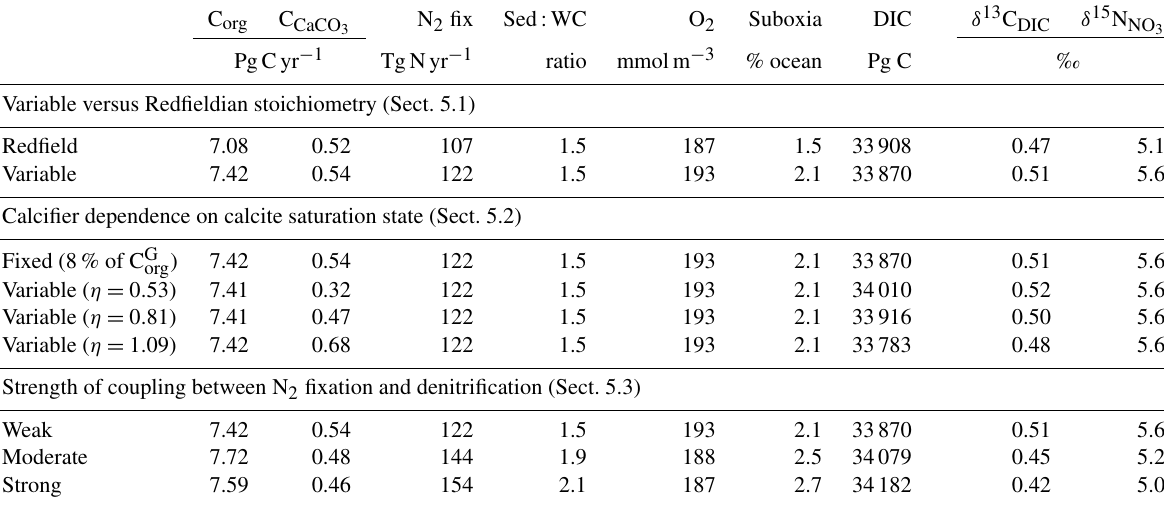
Table 6. Summary of the biogeochemical effects of the different treatments of the ecosystem in CSIRO Mk3L-COAL. C org is the total organic carbon exported from the euphotic zone composed of both general and diazotrophic phytoplankton groups (C G org + C D org ; see Sect. A1 in the Appendix), while C CaCO is the total export of CaCO 3 out of the euphotic zone. The sum of C org and C CaCO 3 of carbon export referred to in the text. Sed:WC refers to the sedimentary to water column denitrification ratio. Note that the global mean δ 13 C DIC is higher than reported in Table 2 because it includes the upper 200m and the